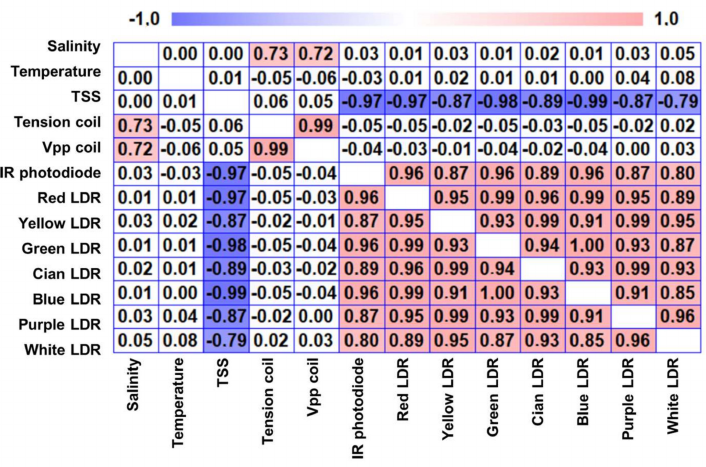
Figure 7. Correlation matrix from the multivariate